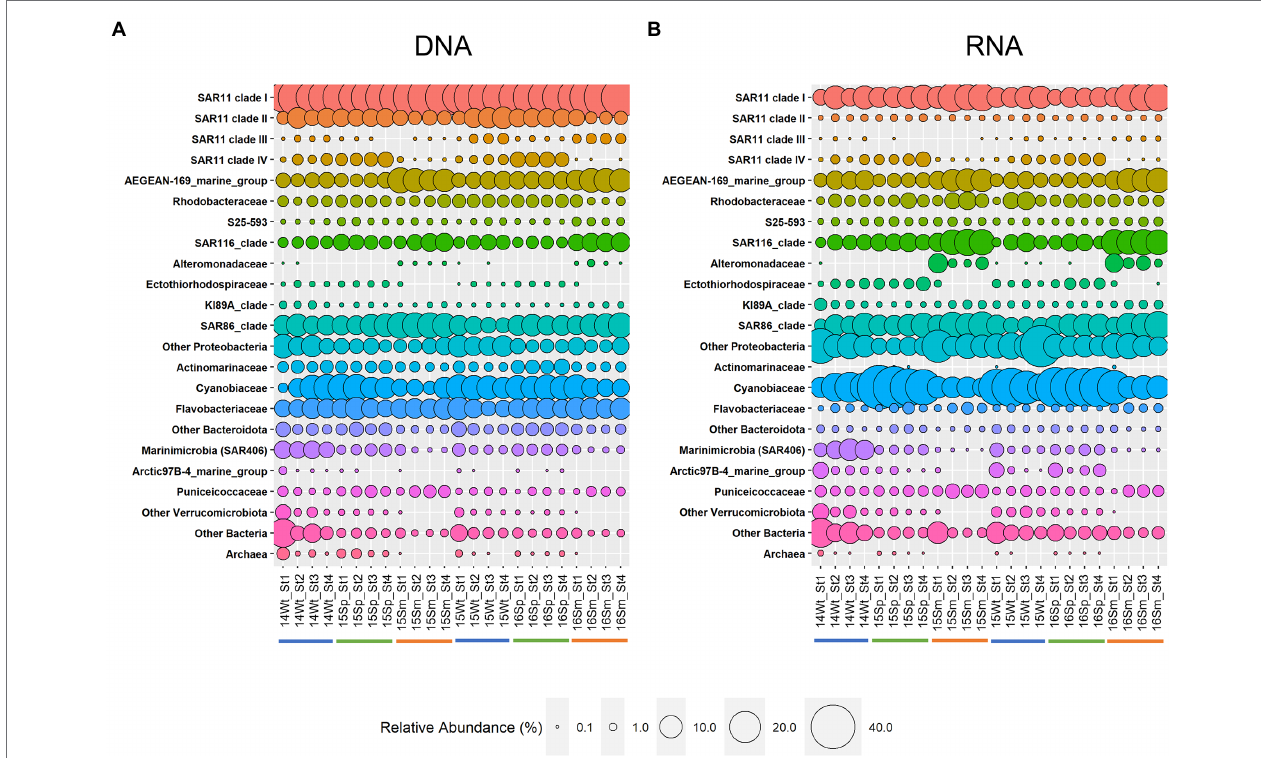
FIGURE 2 | Relative abundance at the family level in DNA (A) and RNA (B) samples. Families with >1% total reads in either DNA or RNA are shown. Families below this threshold are summarized at the phylum level except for the SAR11 clade III. Phyla with <1% of reads in either DNA or RNA are summarized at the domain level. Occurrences of less than 0.1% in a sample are indicated as missing. Sample code: last two digits of collection year (20XX), season (Wt, early winter; Sp, spring; and Sm, summer), and station (St1-4). Color bars under the sample name indicate seasons: blue, winter; green, spring; and orange,